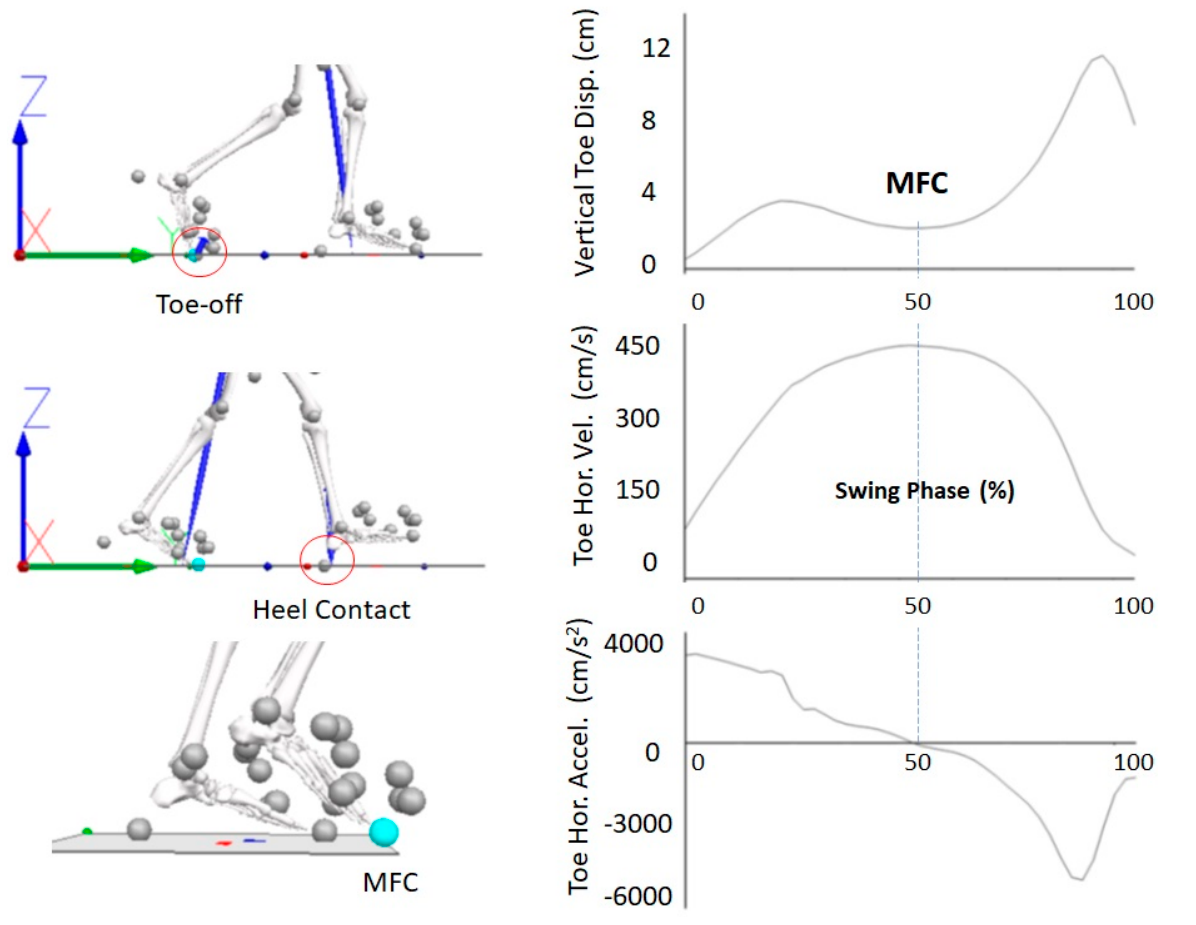
Figure 1. ( Left-top ) toe-off, ( left-middle ) heel contact, and ( left-bottom ) Minimum Foot Clearance (MFC) events; marker setup for foot modelling infrared emitting diodes (IREDs) and virtual markers; MFC, the intermittent event between toe-off and heel contact. ( Right ) Swing-phase kinematics showing: ( right-top ) MFC detection at the local mid-swing minimum vertical displacement, ( right-middle ) MFC coincident with maximum horizontal velocity, ( right-bottom ) MFC timing at zero horizontal acceleration.